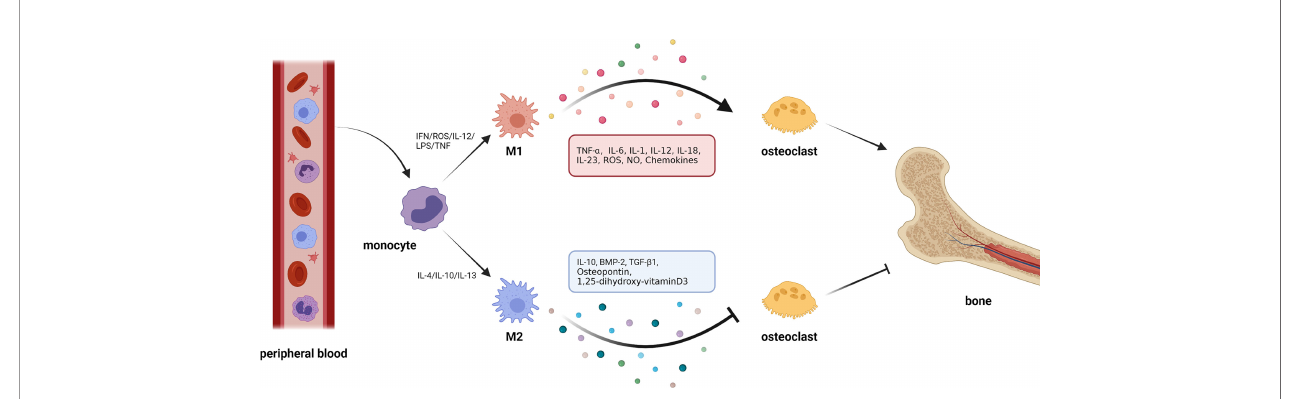
FIGURE 2 | Macrophage polarization and osteoclasts. 1. Circulating macrophages change their phenotype according to the external environment. In the presence of cytokines, such as interferon (IFN), reactive oxygen species (ROS), interleukin-12 (IL-12), and tumor necrosis factor (TNF), macrophages polarize to M1 type. In response to interleukin-4 (IL-4), interleukin-10 (IL-10), interleukin-13 (IL-13), and other cytokines, macrophages can be polarized to M2 type. 2. Macrophages can produce cytokines with opposite effects in different polarization states. M1 macrophages can secrete cytokines, such as tumor necrosis factor- a (TNF- a ), interleukin- 6 (IL-6), interleukin-1 (IL-1), etc., which generally show the effect of activating osteoclasts and promoting bone resorption. M2 macrophages can secrete cytokines, such as IL-10, bone morphogenetic protein-2 (BMP-2), transforming growth factor- b 1(TGF- b 1), etc., most of which can inhibit osteoclastic bone